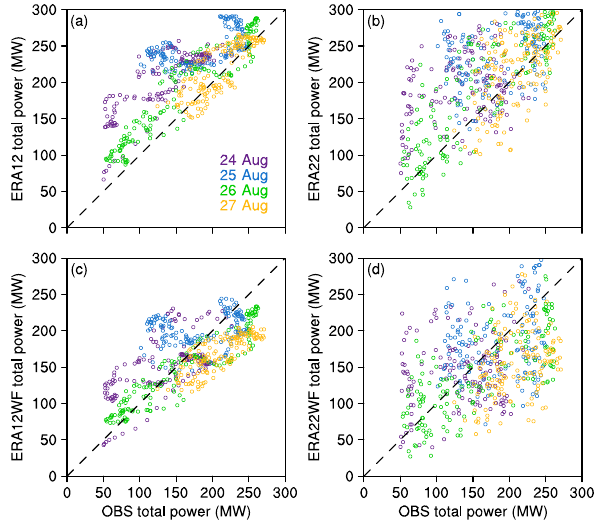
Figure 6. Scatter plots comparing the 10min average observed total wind-farm power over the 4-day period against the calculated total power from the ERA12 (a) and the ERA22 (b) , and the simulated total power from the ERA12WF (c) and the ERA22WF (d) . The dots represent the total power productions on 24 August (purple), 25 August (blue), 26 August (green), and 27 August (yellow).